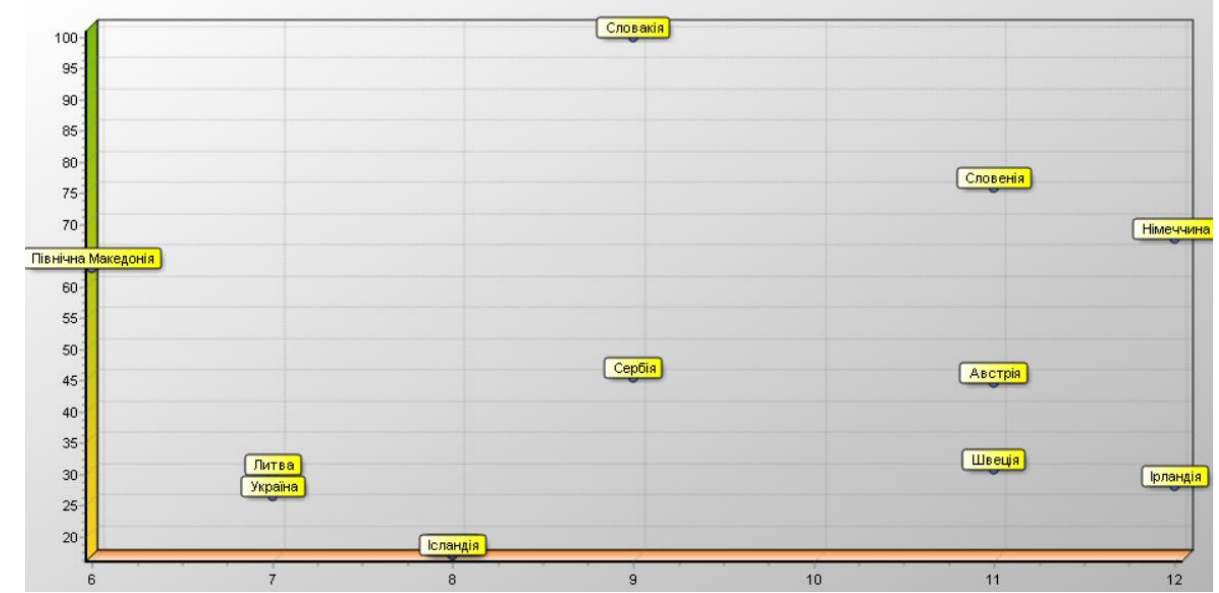
Figure 5. Graph of countries’ efficiency (for the 2 nd group of the 2 nd cluster)